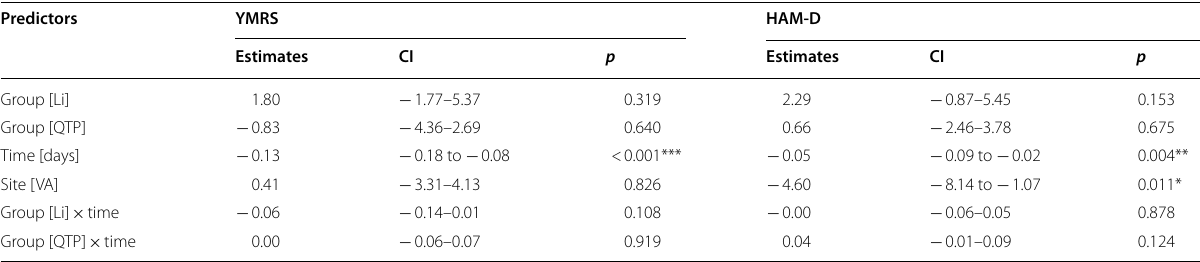
Table 5 Longitudinal Outcomes in YMRS and HAM-D: monotherapy versus individual combination therapies